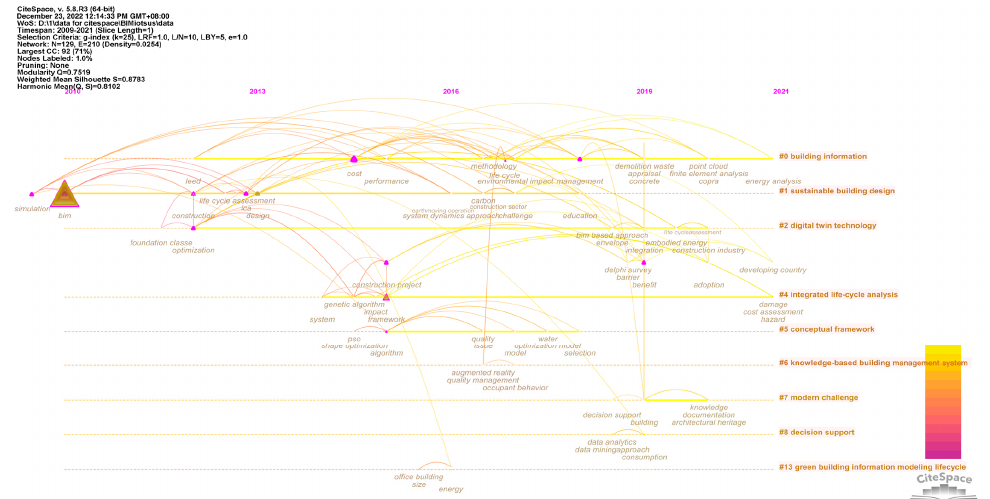
Figure 8. Keyword co-occurrence timeline of co-citation clusters in Figure 7 (generated by the